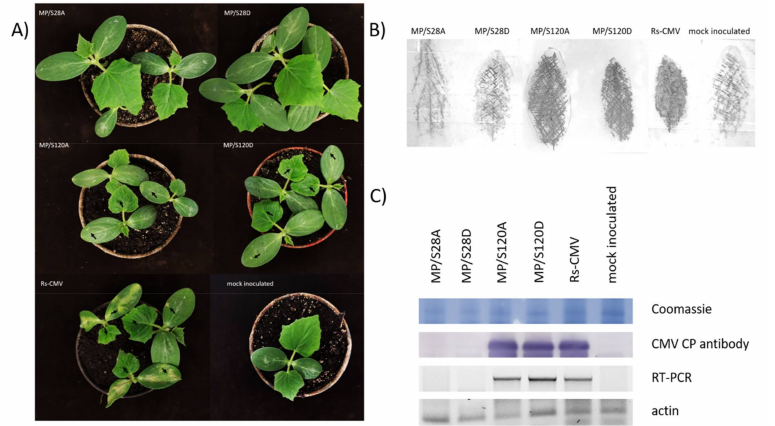
Figure 2. Symptom formation on Cucumis sativus plants 10 dpi inoculated with wild type Rs-CMV or movement protein (MP) mutants: MP/S28A, MP/S28D, MP/S120A, MP/S120D. ( A ) The cotyledons were inoculated with purified virions and systemic symptoms were observed. The mosaic symptoms on the young leaves and the local necrotic lesions on the cotyledons were marked with arrows. ( B ) Tissue print immunoassay of inoculated cotyledons at 10 dpi. ( C ) Systemic infection of the mutant viruses was analyzed by Western blot analysis and RT-PCR.